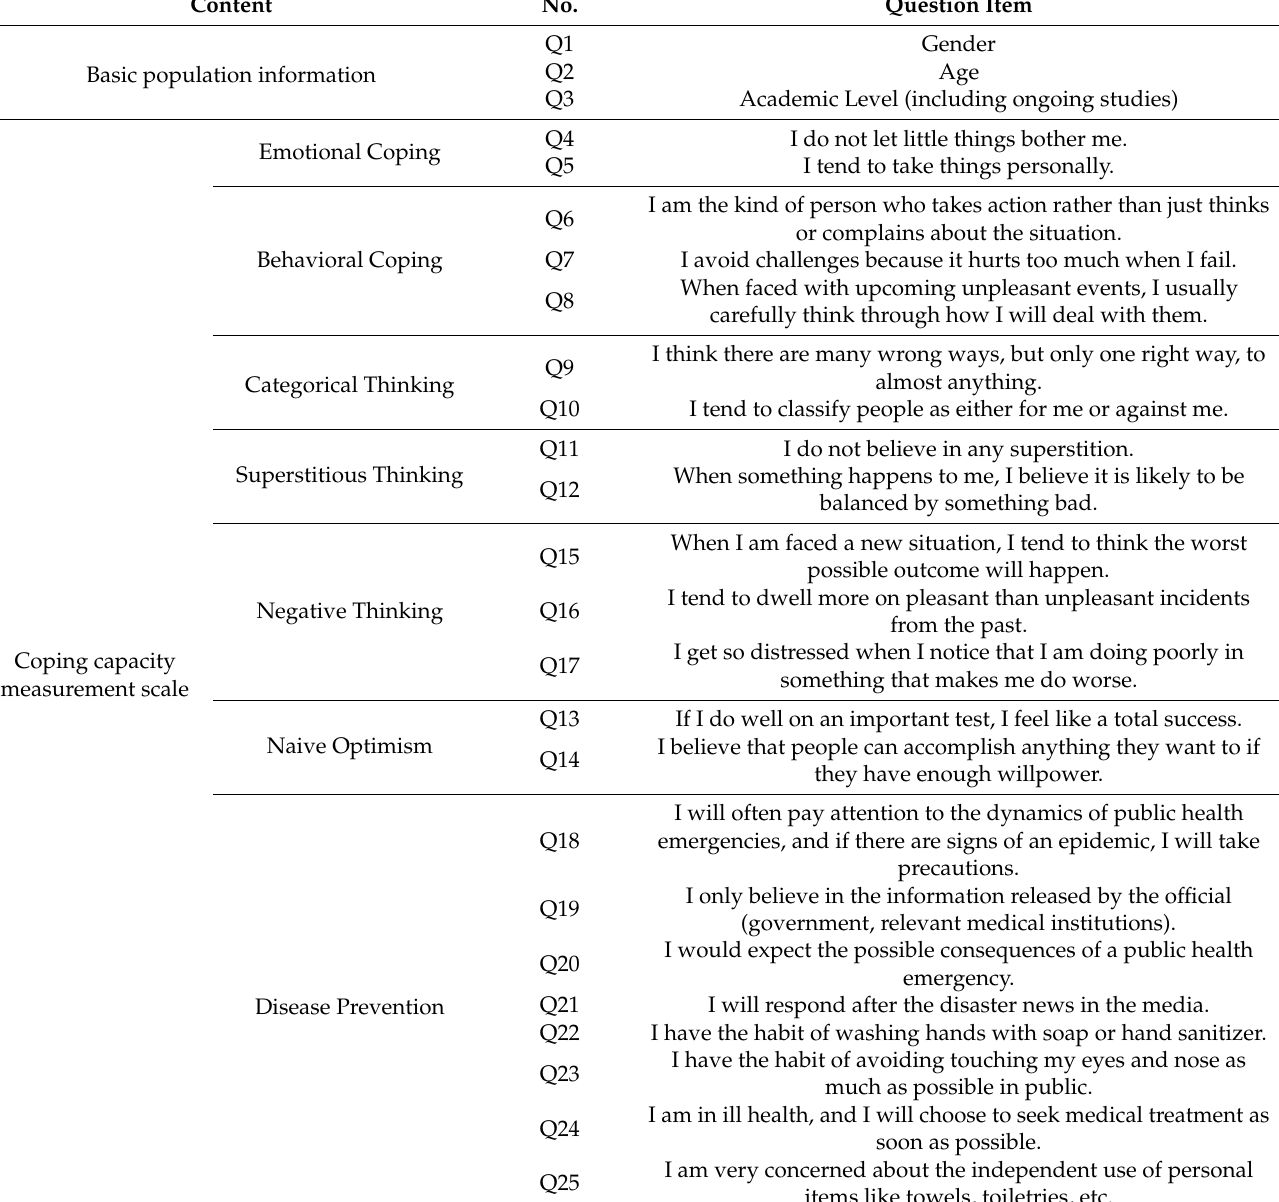
Table A1. Predictive test